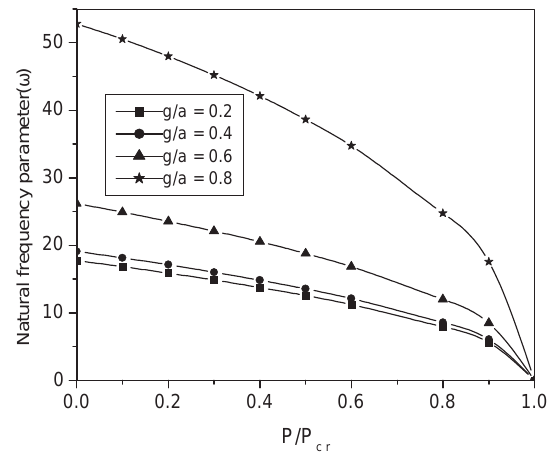
Fig. 9. Frequency parameters for a stiffened square plate having one centralstiffenerwithsquarecutoutsubjectedtouni-axialcompressive forces.